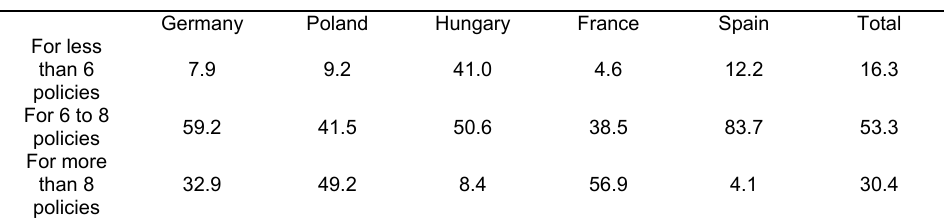
For how many of the twelve policies do subnational administrators’ responses correspond with efficient competence